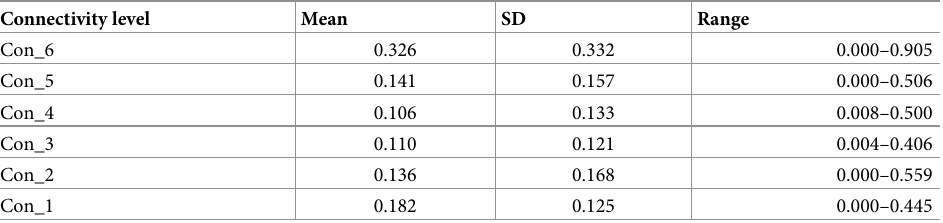
Table 5. Summary statistics of the six connectivity levels of the dependent variable (proportion of time